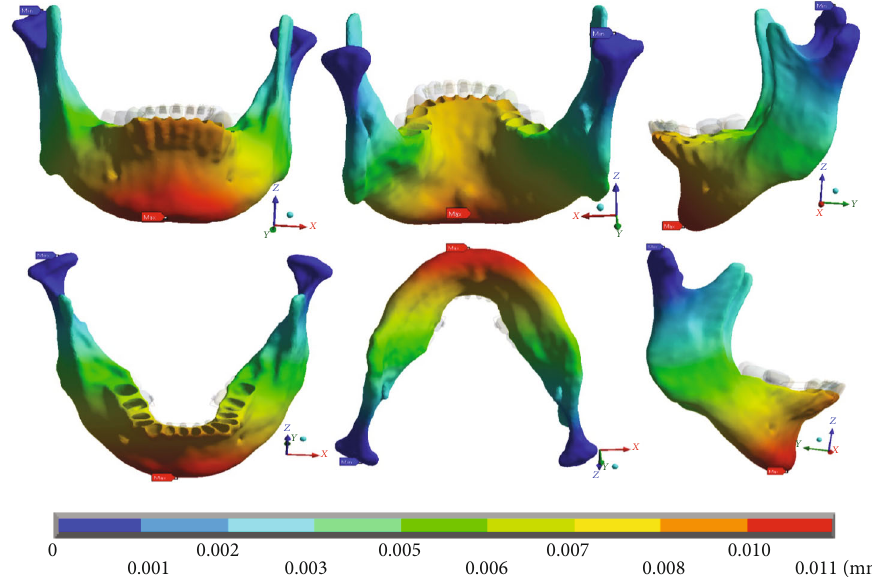
Figure 11: Total deformation that occurs in the mandibular bone. The red marker indicates the maximum deformations, and the blue marker indicates the minor deformations.